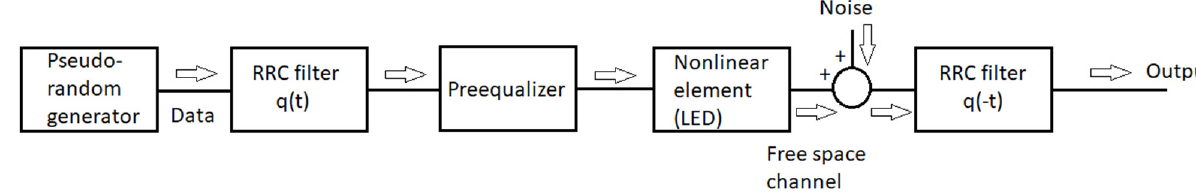
Figure 4. Pre-equalizer configuration.